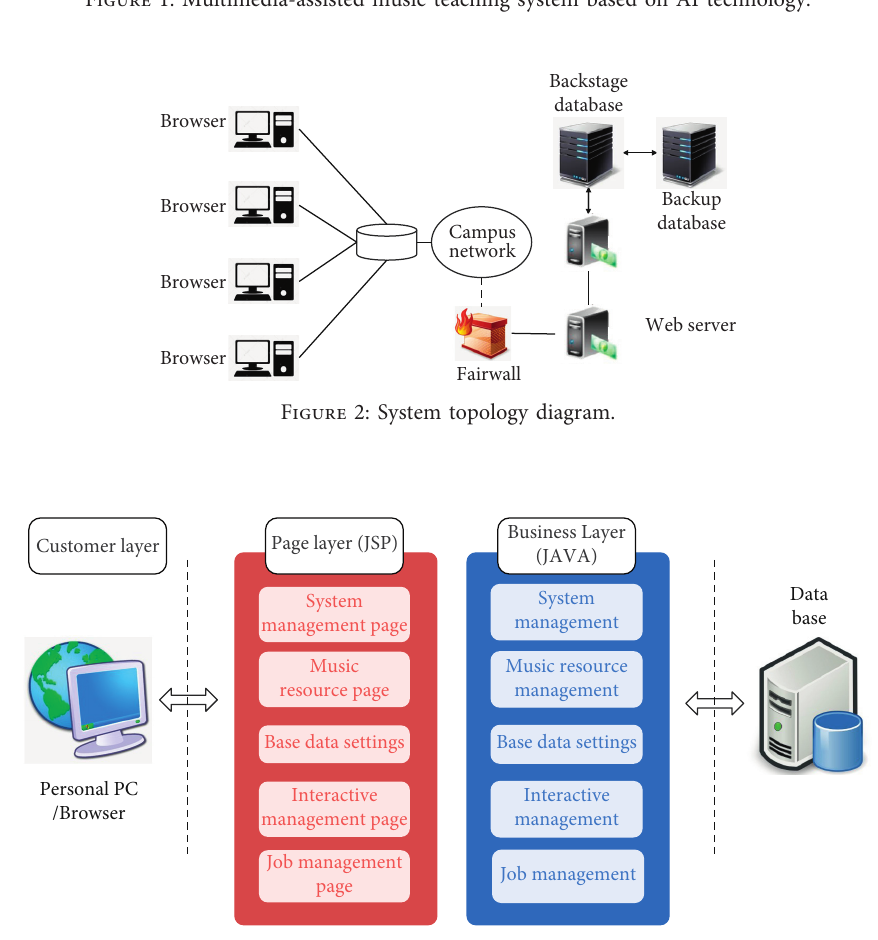
Figure 3: Architecture